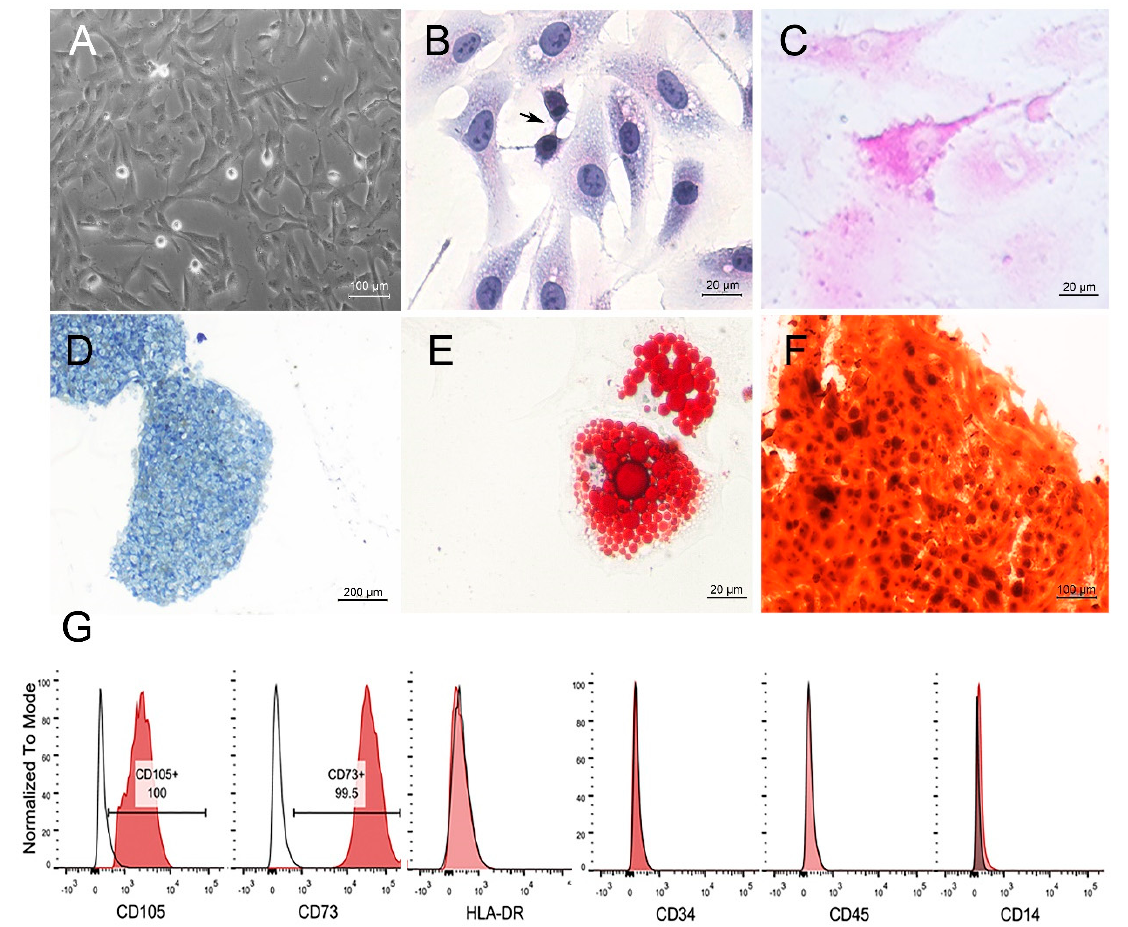
Figure 1. Urine stem cells (USCs) characterization; ( A ) Phase–contrast light micrograph (LM) at passage zero showing stellate shaped cells with membrane projection reaching nearby cells (original magnification × 100, scale bar = 100 µ m). ( B ) hematoxylin and eosin staining of USCs at passage three, showing basophilic stellate cells with perinuclear eosinophilia, large central nuclei, and cytoplasmic projections Actively dividing cells were occasionally seen represented by kissing cells (arrow) (original magnification × 400, scale bar = 20 µ m). ( C ) Periodic acid–Schiff (PAS) staining of USCs at passage three, showing perinuclear magenta color (original magnification × 400, scale bar = 20 µ m). ( D ) Toluidine Blue staining of USC pellet following chondrogenic differentiation showing blue staining proteoglycan–rich extracellular matrix (original magnification × 40, scale bar = 200 µ m). ( E ) Oil Red O staining of the induced adipogenic cells showing red staining of intracellular lipid (original magnification ×400, scale bar = 20 μ m). ( F ) Alizarin Red staining of induced osteogenic cells showing a dark orange discoloration of the calcification nodules (original magnification ×100, scale bar = 100 μ m). ( G ) A representative sample of immune phenotypical characterization of 10 5 USCs (shaded curve) showing positive expression of CD105, CD73, and negative for HLA–DR, CD34, CD45, and CD14.